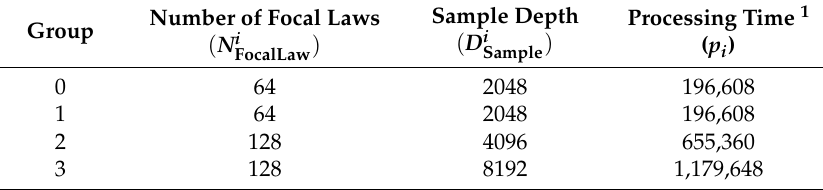
Figure 11. Four groups scheduled in two fine delay modules’ simulation by ModelSim. Table 4. Four groups of two fine delay modules simulation